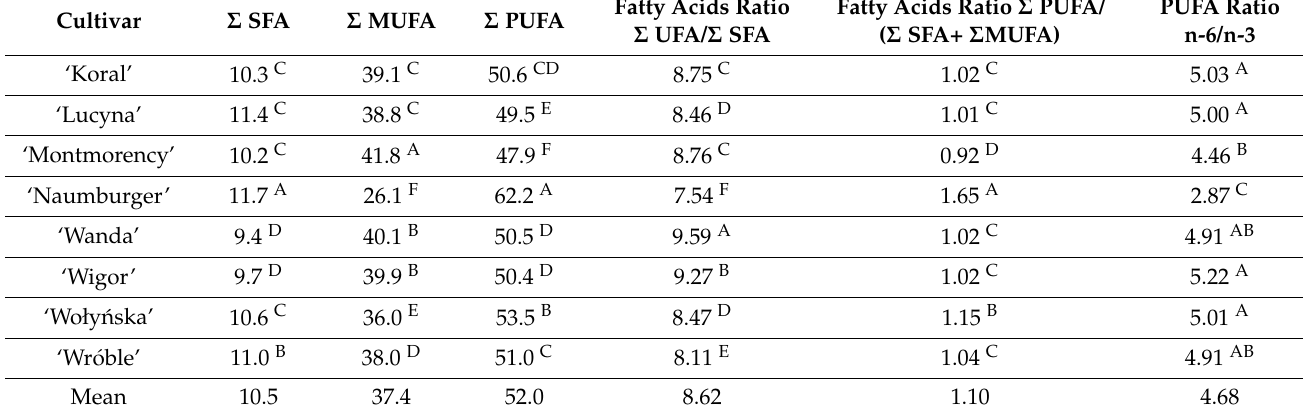
Table 4. Sum of SFA, MUFA, and PUFA (%), and fatty acid ratios of sour cherry kernel